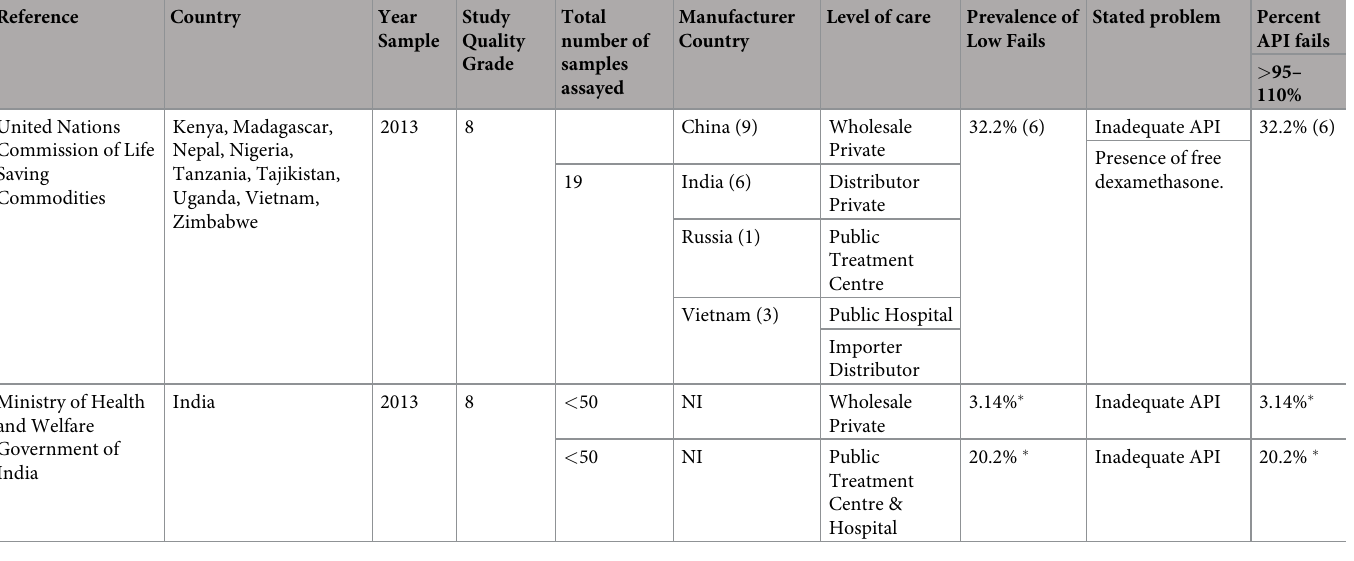
Table 2. Characteristics and quality parameters of included